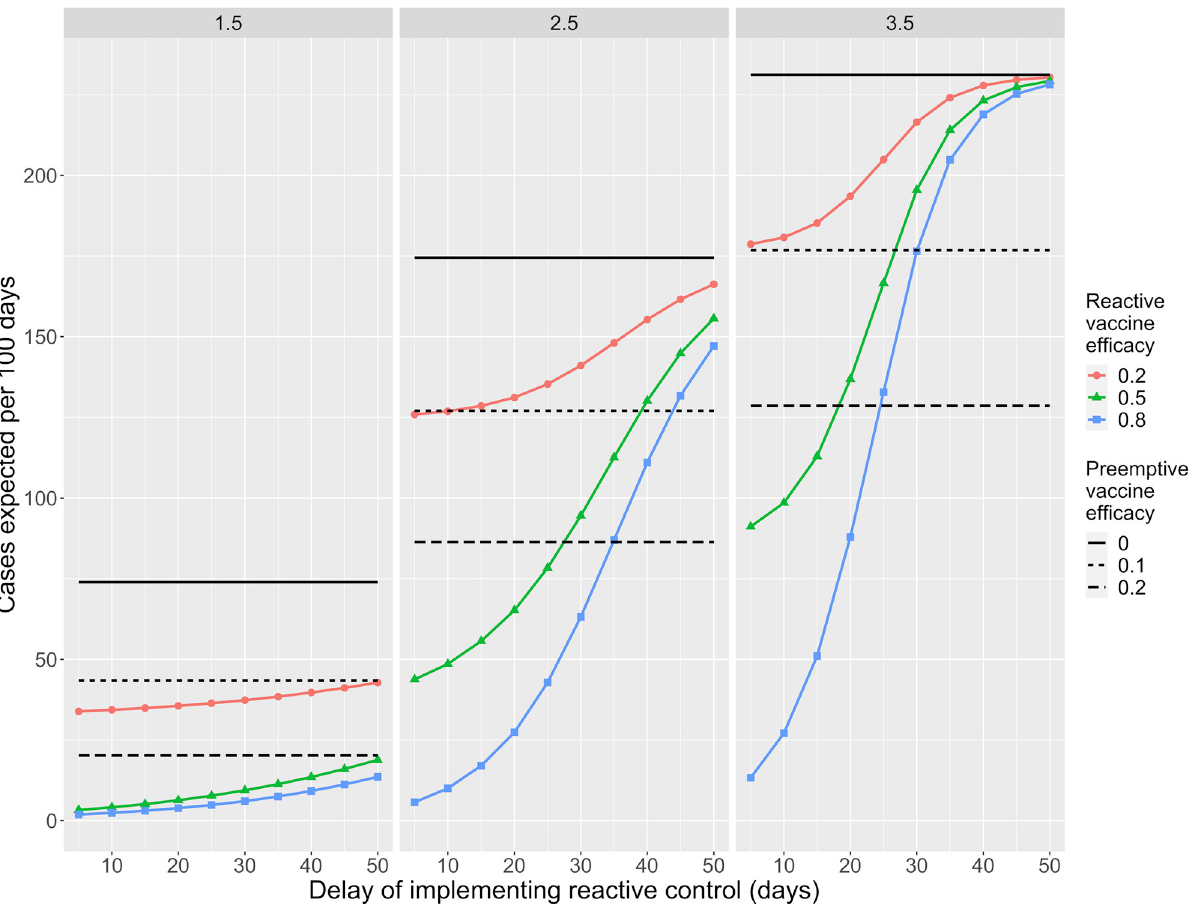
Fig 6. Preemptive vs reactive control. The number of cases per 100 days is shown as a function of different types of control. Each vertical panel corresponds to a different value of R B as depicted on the top bar. Horizontal black bars correspond to no control being implemented. Horizontal dashed bars correspond to preemptive density-dependent control, in which immunity from density-dependent control has been achieved before an outbreak begins. The individual-level efficacy of preemptive control ( γ ) is indicated in the lower legend. Colored curves indicate the expected number of cases when reactive control is implemented once ten cases in a residential unit are identified. We model reactive control as being equally effective at reducing both disease and transmission after a predetermined control delay. The delay is depicted on the x-axis and the individual-level efficacy of reactive control ( γ r ) is depicted in the upper legend. Parameter values are otherwise identical to those in Fig